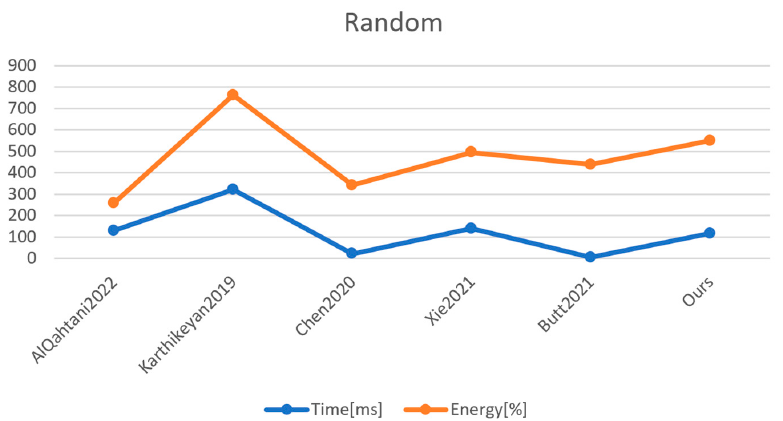
Table 10. Execution time of the TLS handshake using the MICAz sensor.